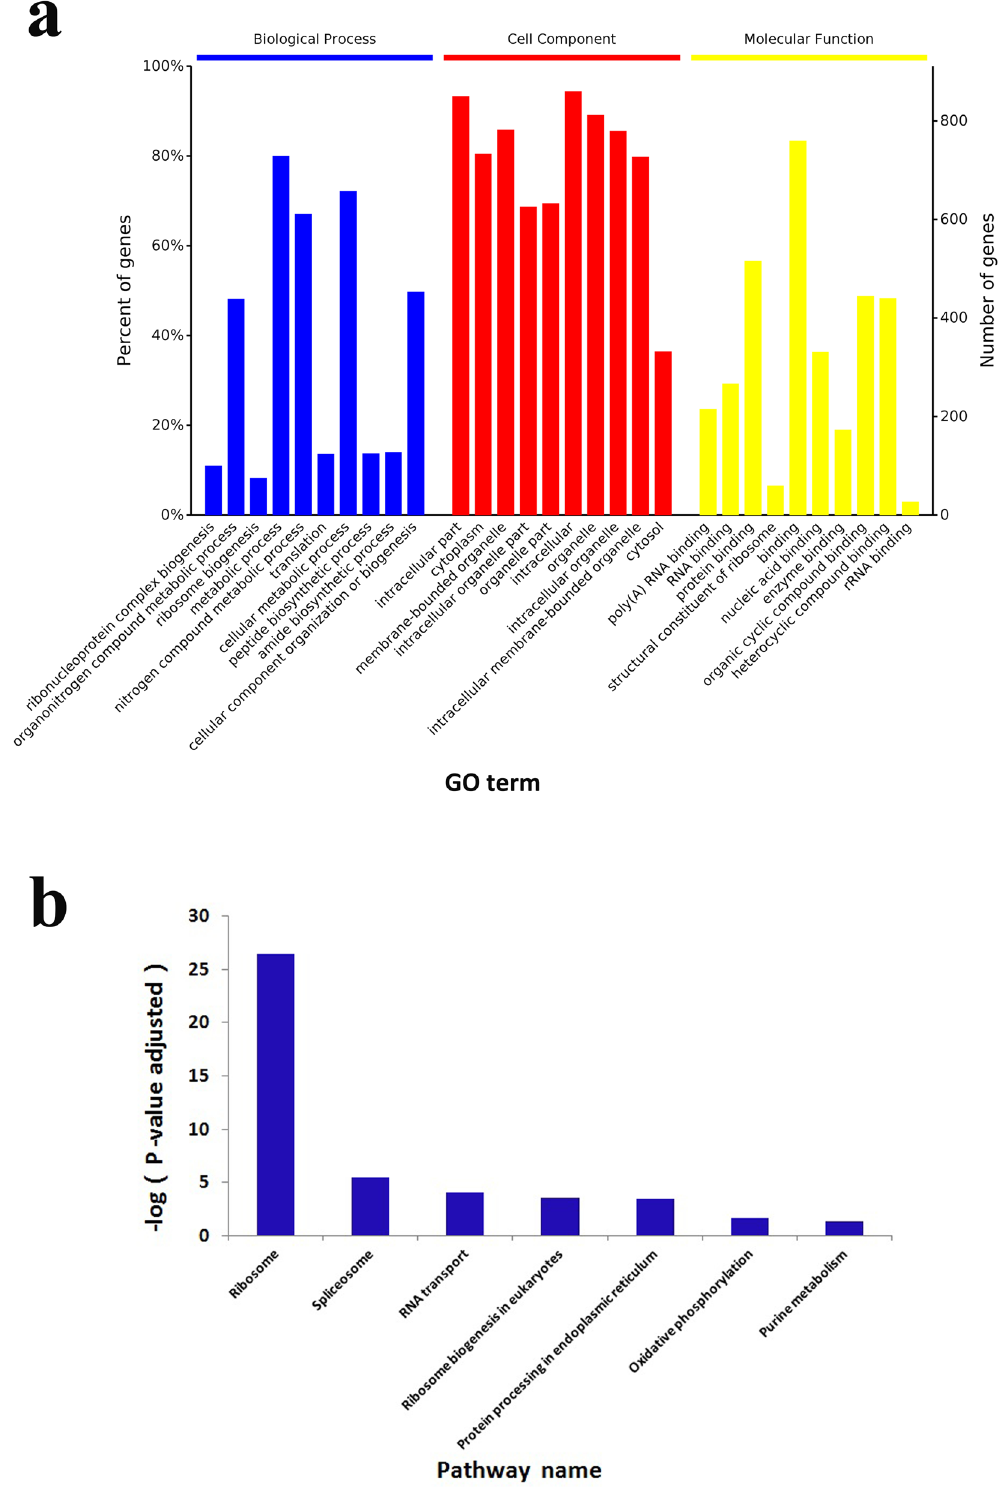
Figure 6. GO and KEGG enrichment analysis of differentially abundant proteins. ( a ) GO analysis result. ( b ) KEGG pathway analysis